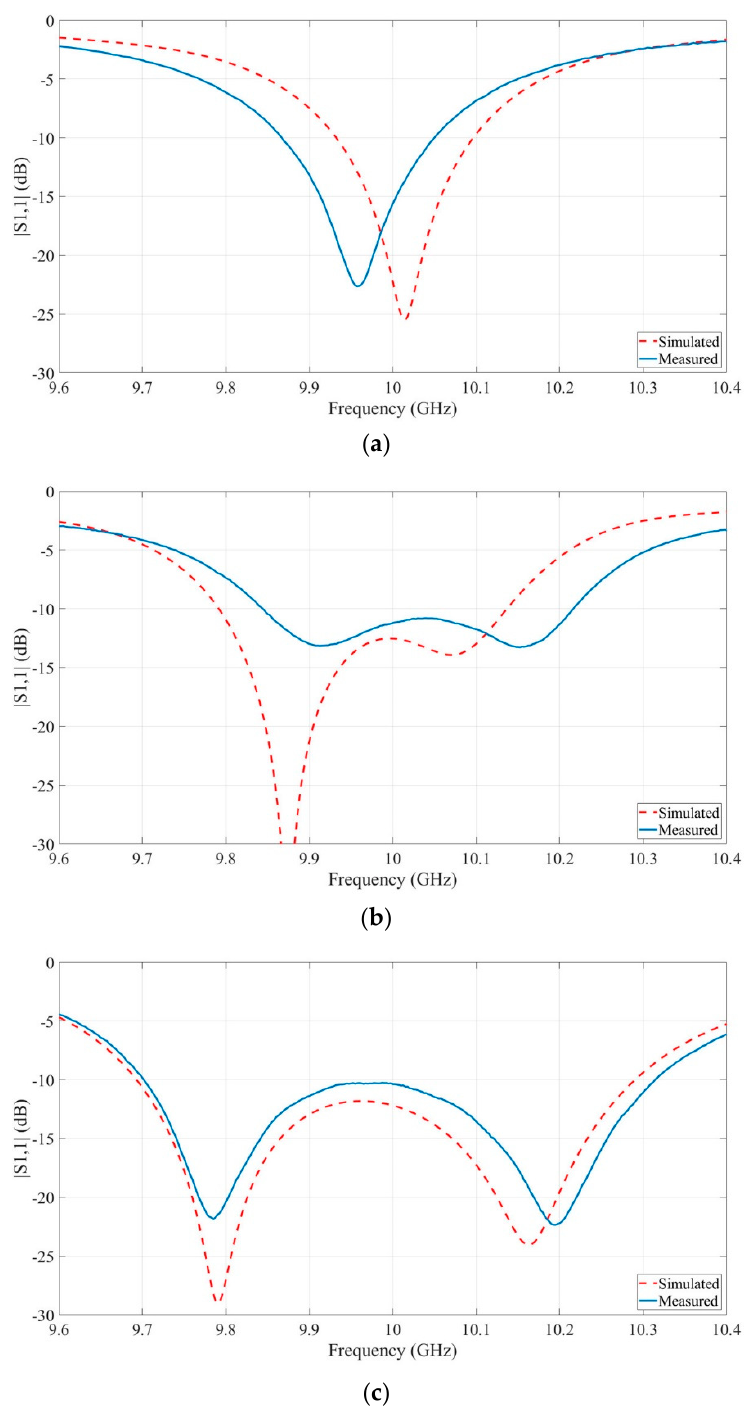
Figure 16. Comparison between simulated and measured results: ( a ) MPA1, ( b ) MPA2, ( c ) MPA3.